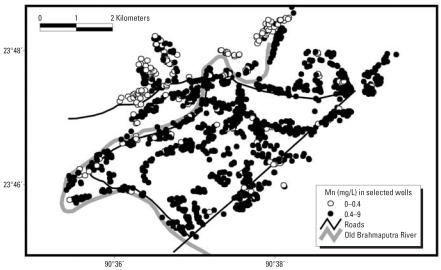
Map of wells with known manganese concentration in the 26-km2 study site, according to manganese levels (< 0.4 mg/L vs. ≥ 0.4 mg/L) (n = 1,299 wells).